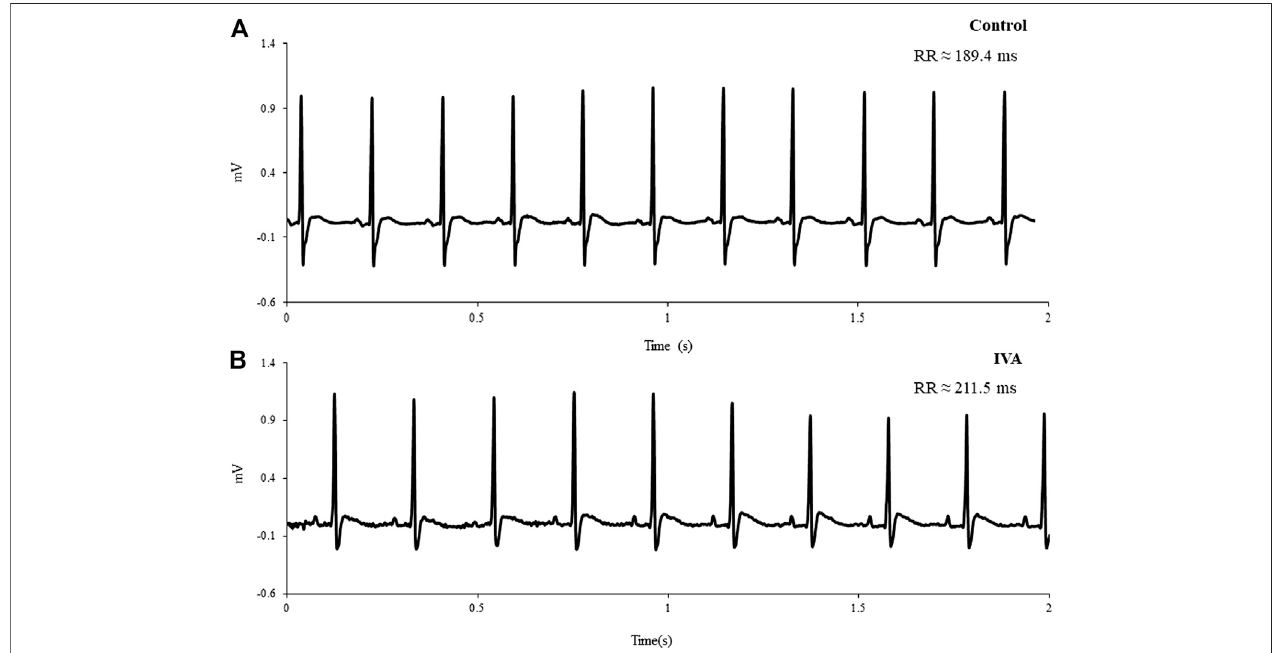
FIGURE 2 | Representative telemetric ECG tracings recorded in a Control (A) and an ivabradine-treated (IVA) rat (B)